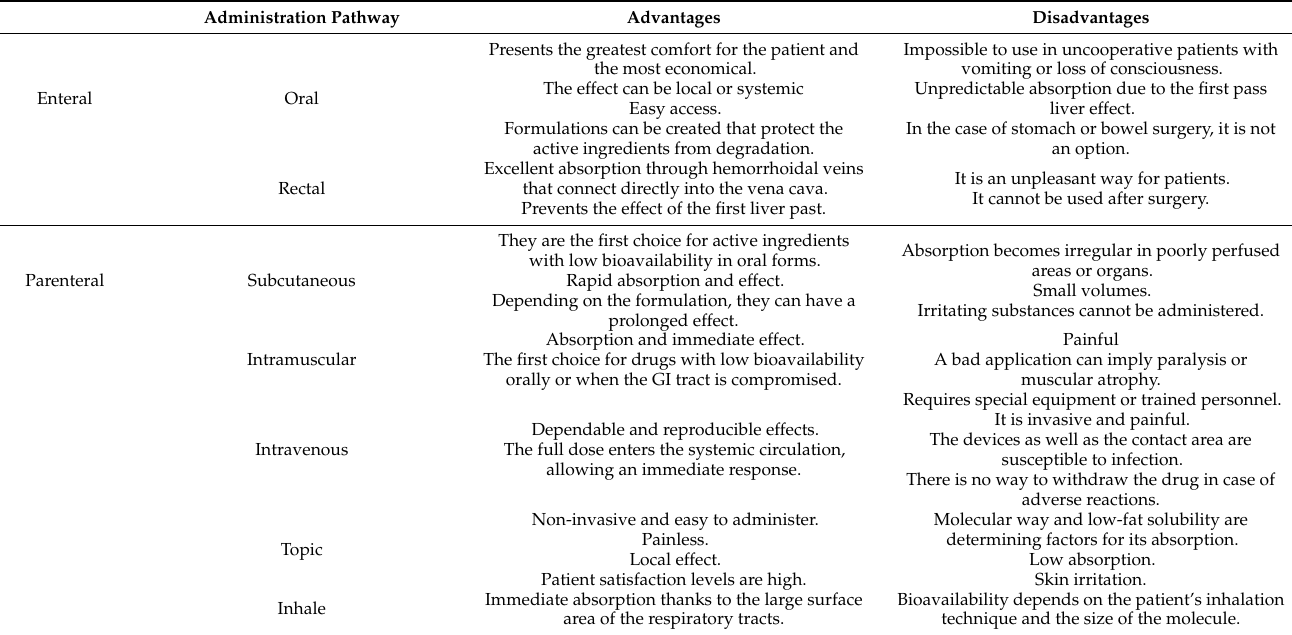
Table 1. Advantages and disadvantages of oral administration vs. other